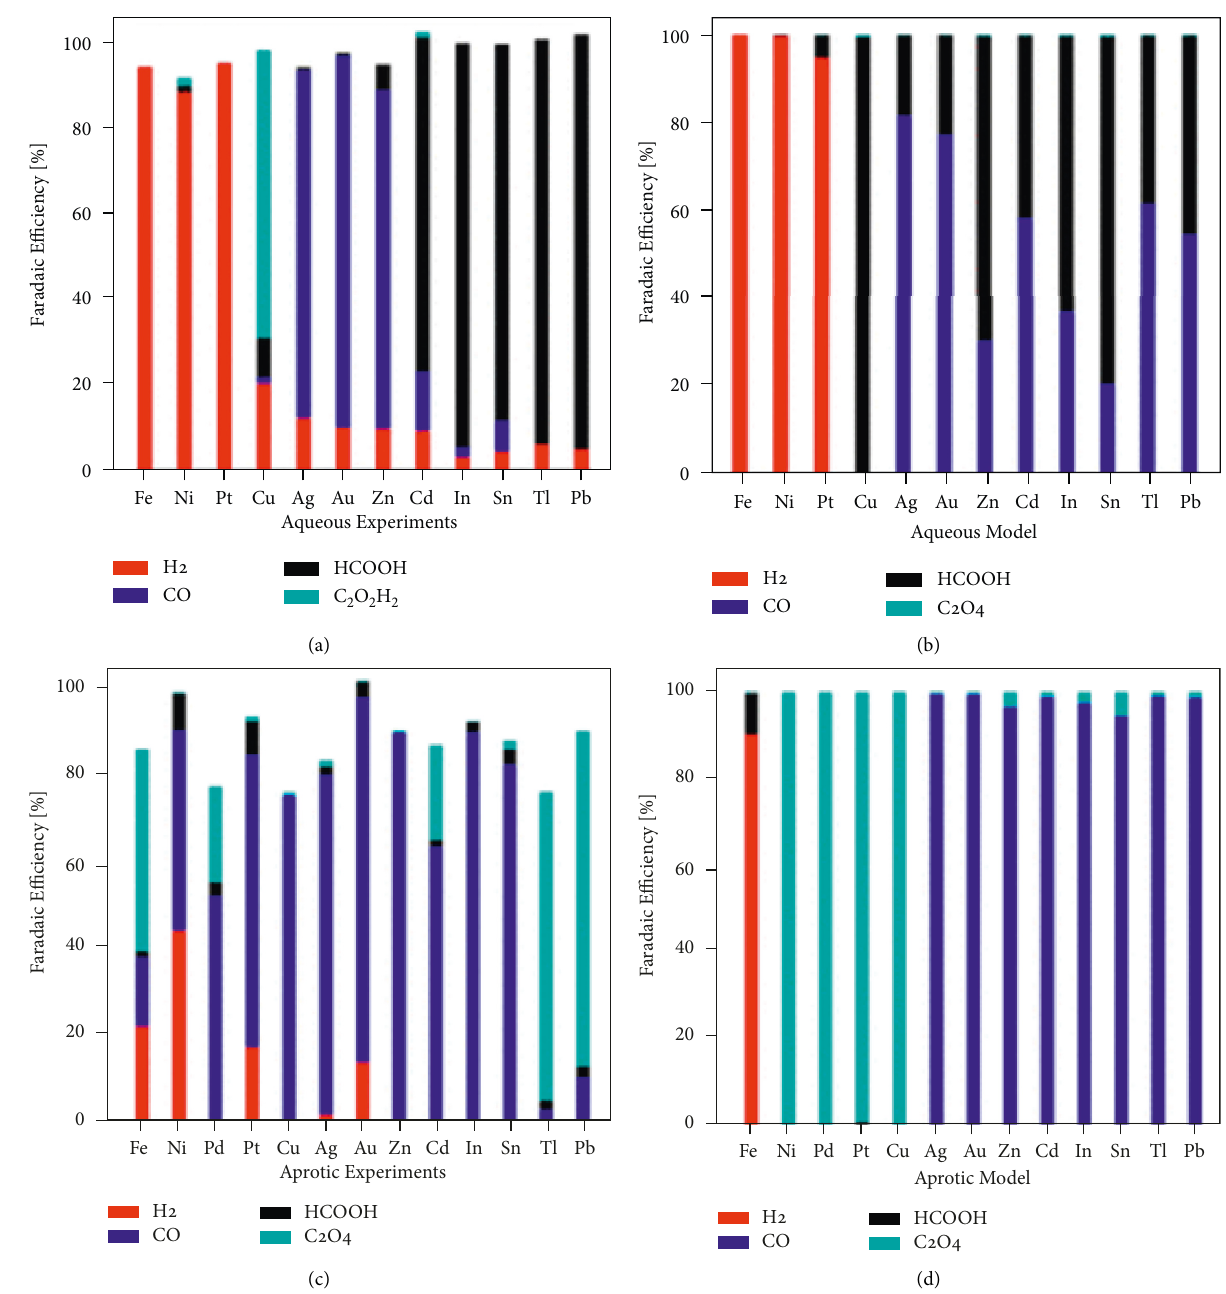
Figure 10: Comparison of the Faradaic efficiencies of products from CO 2 reduction reaction experiments in (a) aqueous and (c) aprotic phases and the predicted product distribution from the microkinetic model in (b) aqueous and (d) aprotic phases from [75] under the terms of the Creative Commons CC BY